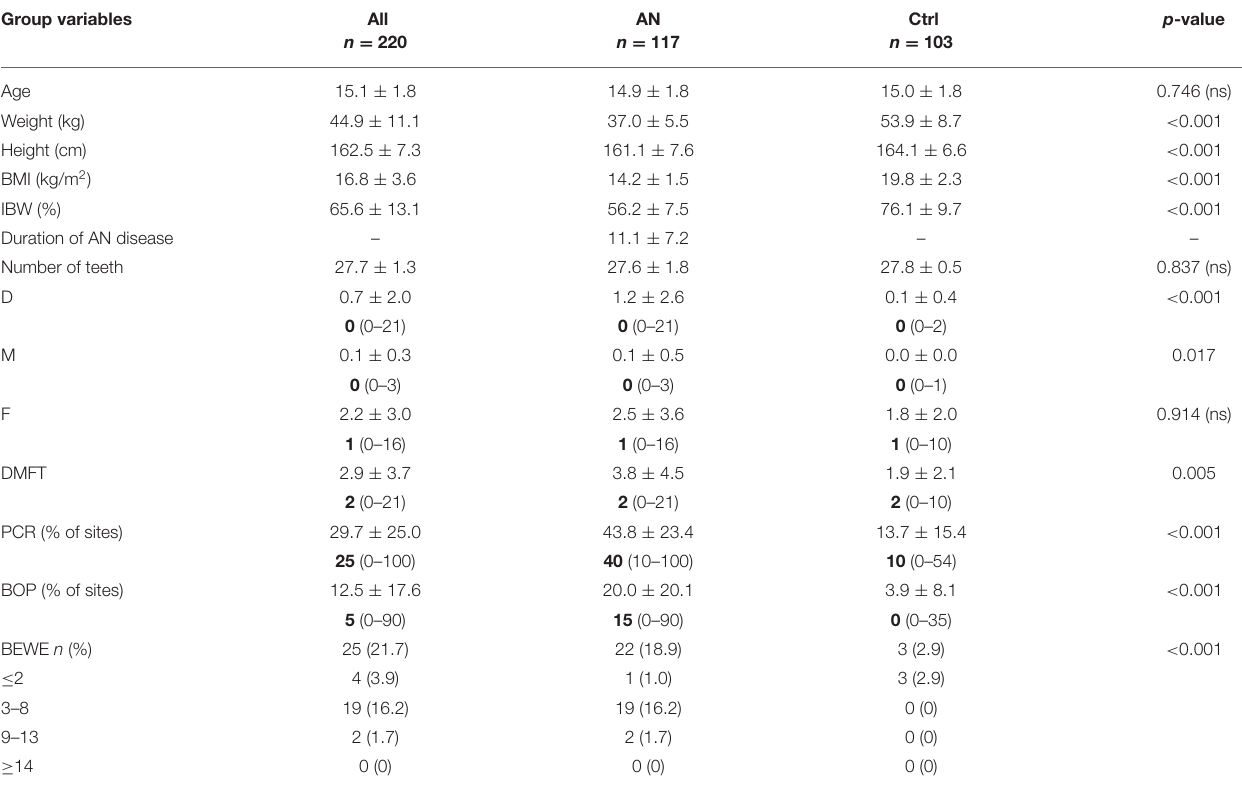
TABLE 2A | Comparison of anthropometric and oral parameters between AN patients and controls. Group variables